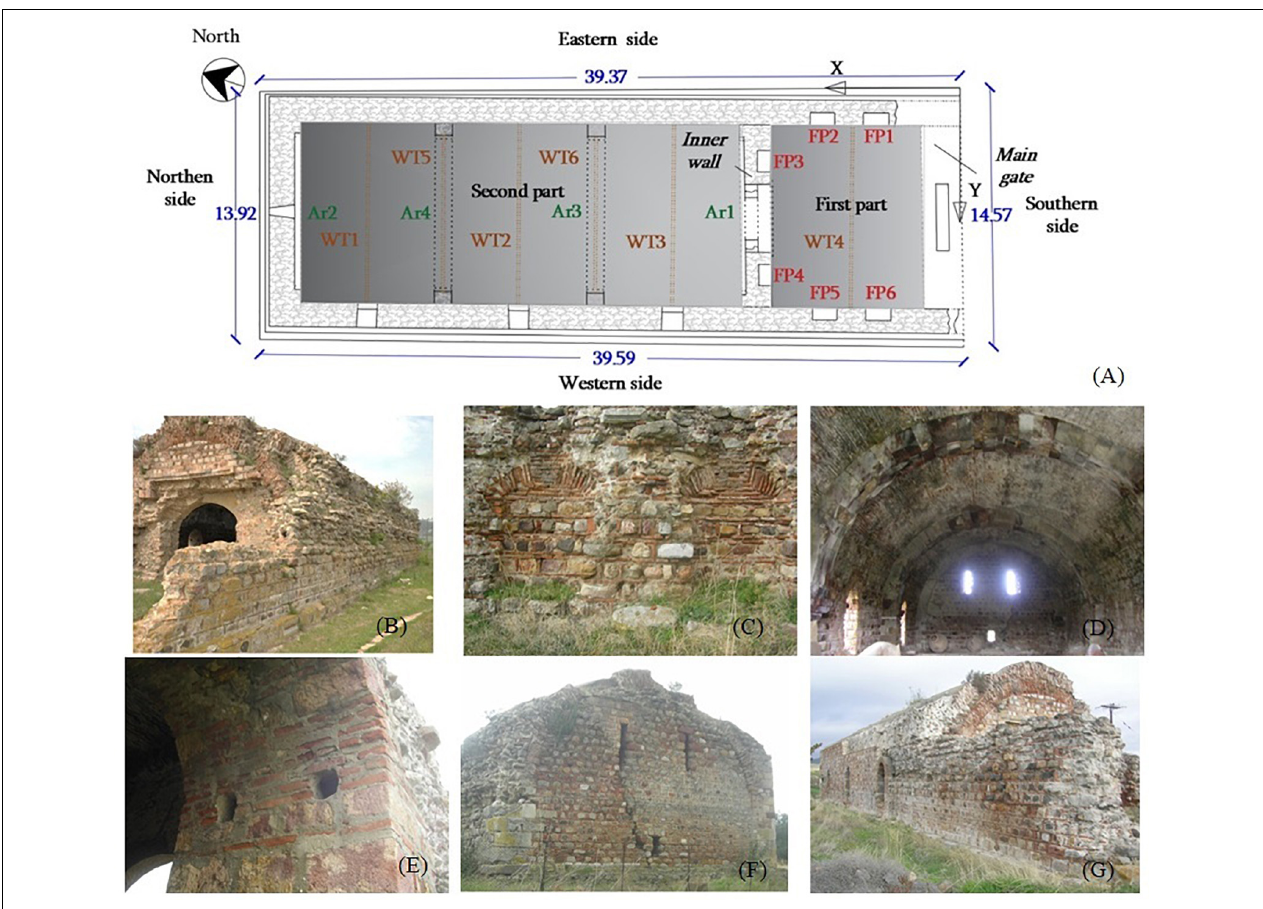
FIGURE 1 | (A) Monument’s plan. (B) Eastern side and inner wall. (C) Fire places. (D) Stone arches. (E) Square holes for wooden tendons. (F) Northen side. (G) Western